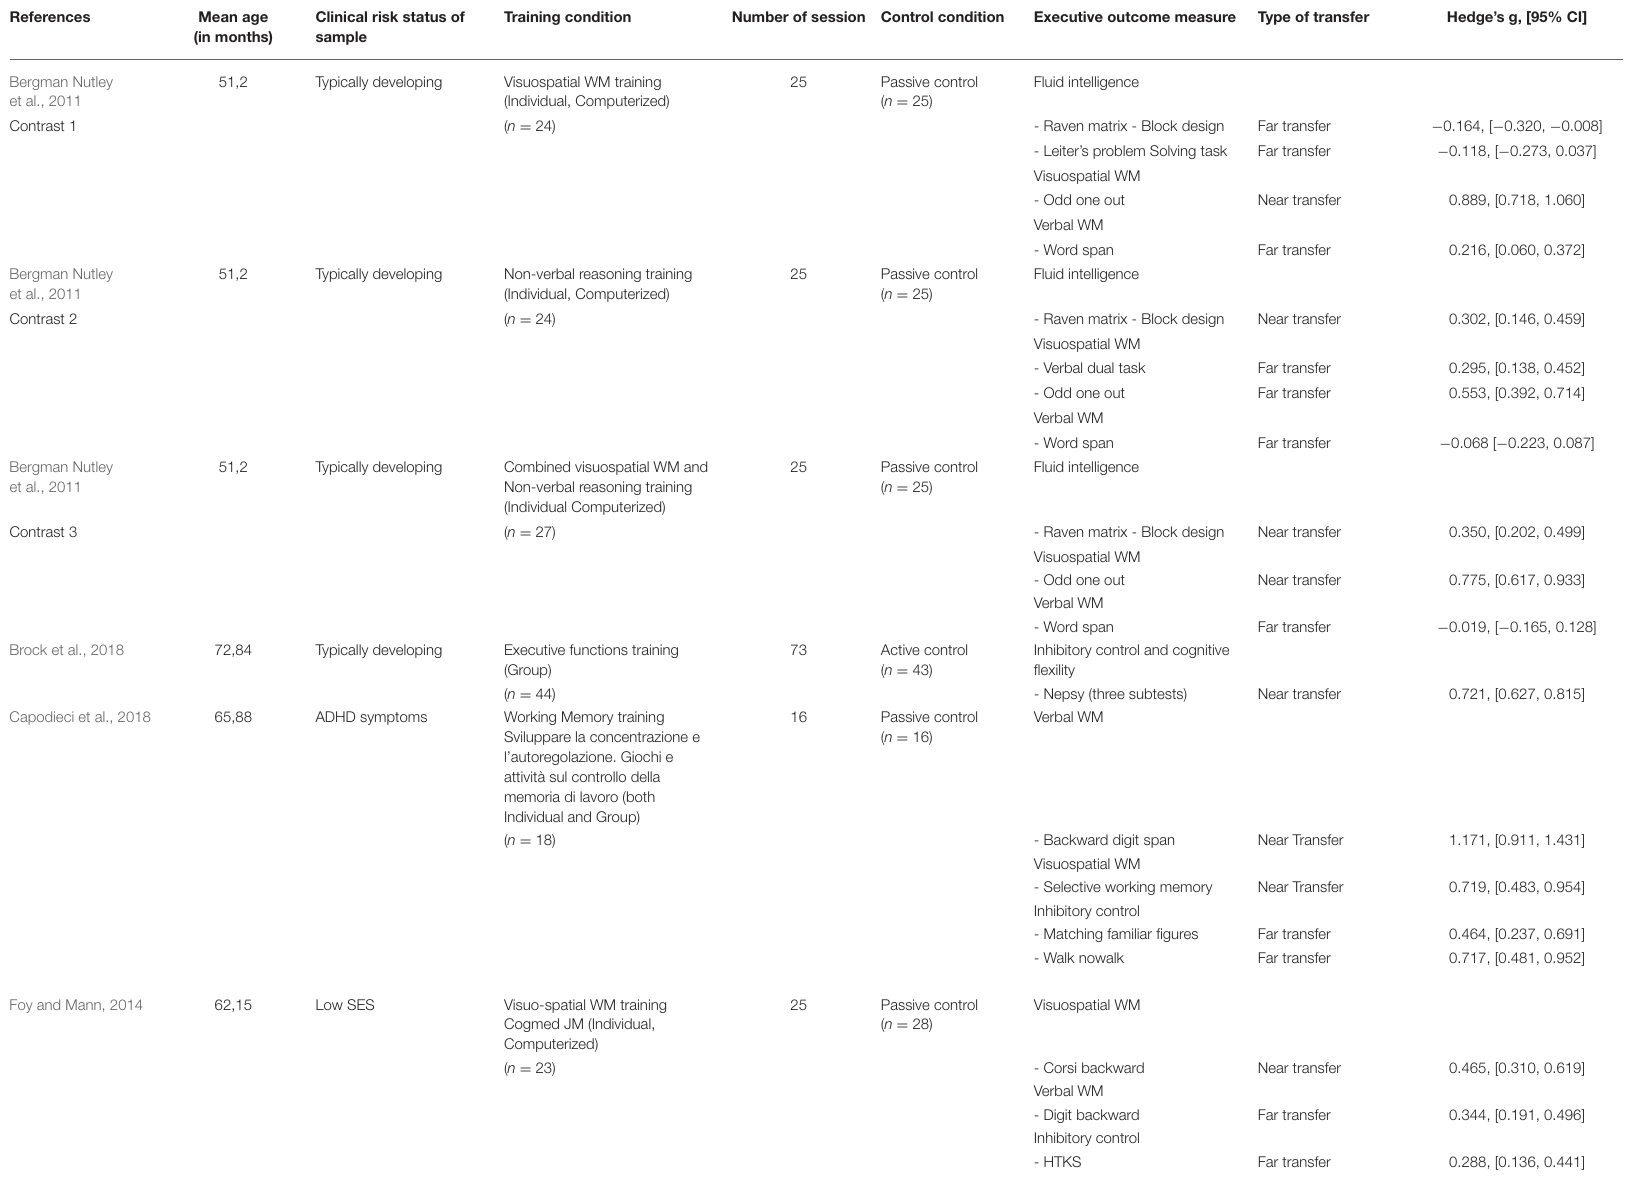
TABLE 1 | Summary of the studies included into the meta-analysis: EF outcome measures and Near vs. Far Transfer